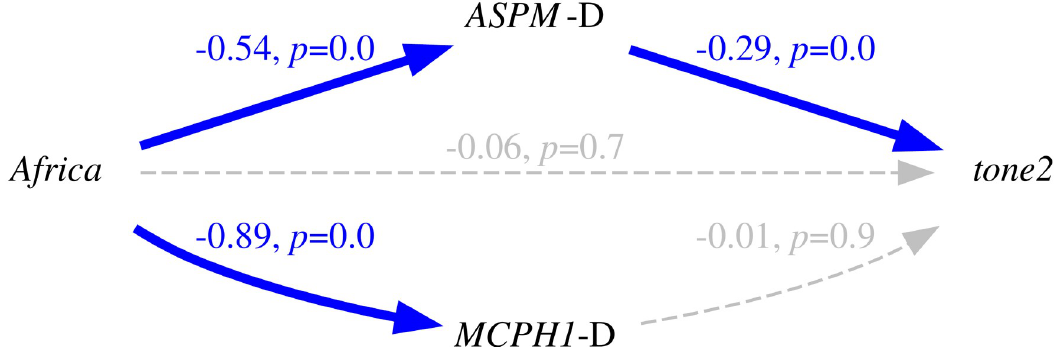
Fig 22. The path model for tone2 fitted on all the data. Same conventions as in Fig 13.